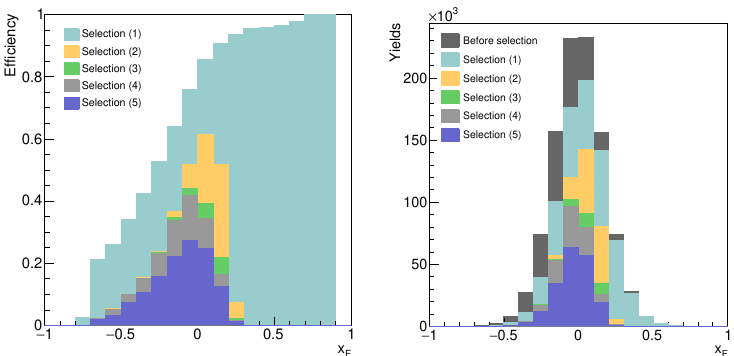
Figure 7 . The estimated detection e(cid:14)ciency as a function of x F (left) and the x F distributions after the selection (right). Selection (1){(5) are given in table 1.